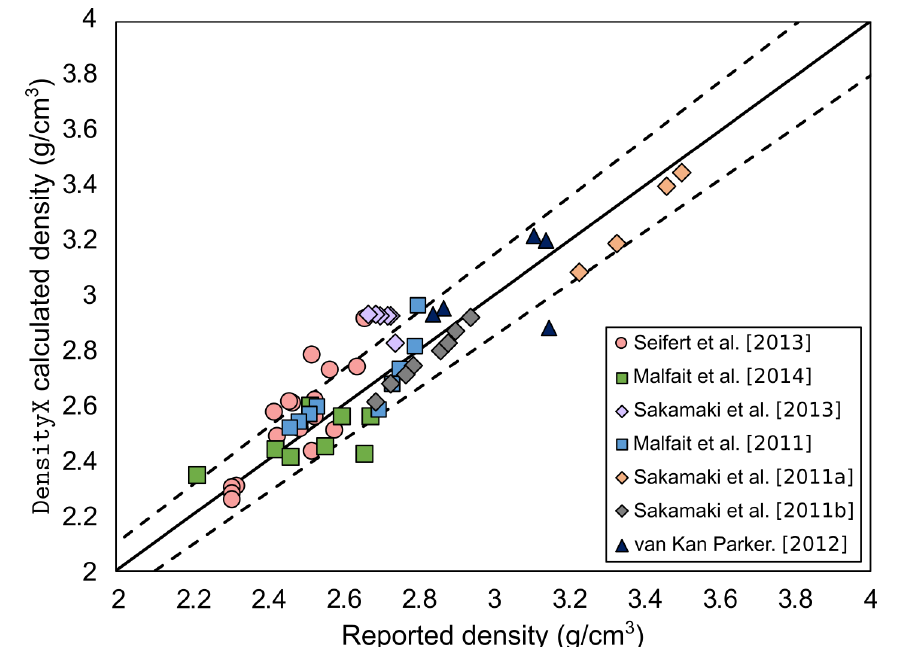
Figure 3: Comparison of silicate melt densities calculated with DensityX and measured in situ at high P and T . Black line is a 1:1 line. Dashed lines represent a 2 σ error envelope, equivalent to 5% relative. Reported densities are for: phonolitic melts [Seifert et al. 2013]; andesitic melts [Malfait et al. 2014]; basaltic melts [Sakamaki et al. 2013]; haplogranite, andesite, and basalt melts [Malfait et al. 2011]; high-Ti lunar basalts [Sakamaki et al. 2010a; van Kan Parker et al. 2012]; and peridotite melt [Sakamaki et al.